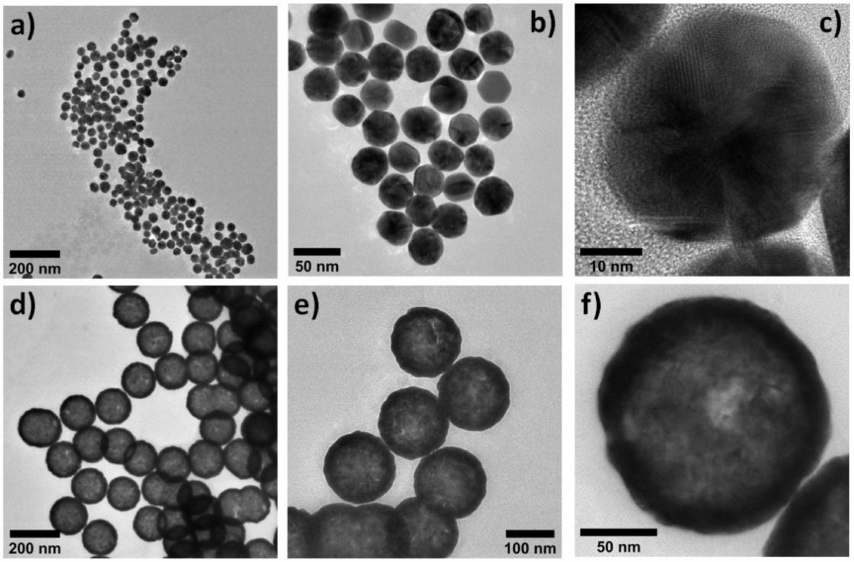
Figure 2. ( a – c ) TEM images of 40 nm gold nanoparticles. ( d – f ) TEM images of 150 nm gold